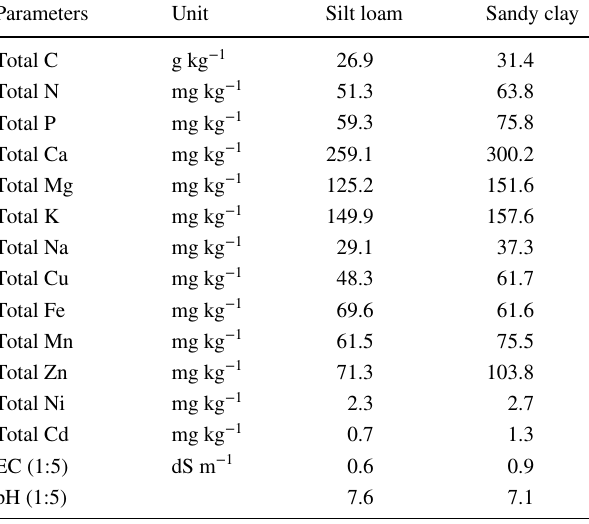
Table 2 Chemical composition of soils used for the study Parameters Unit